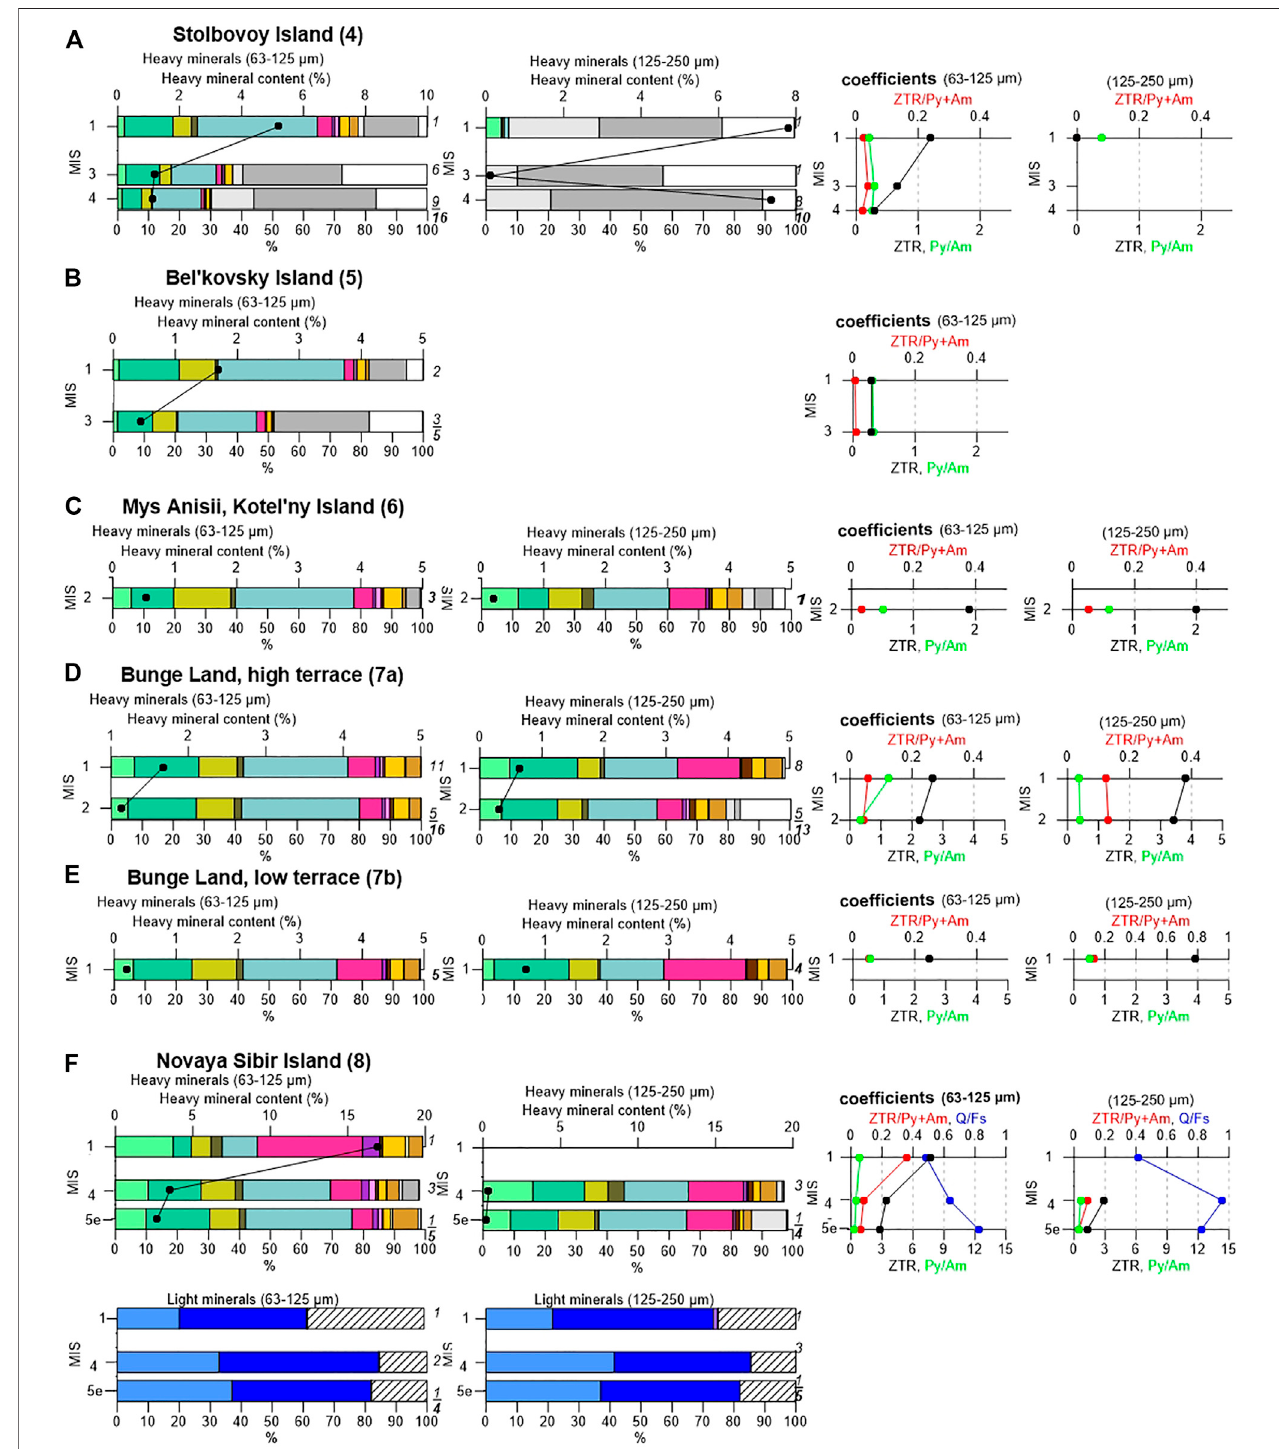
FIGURE 3 | Heavy and light mineral associations of the fi ne and coarse fractions, the heavy mineral contents, and the corresponding mineral coef fi cients from the northern New Siberian Islands: (A) Stolbovoy Island (4), (B) Bel ’ kovsky Island (5), (C) Mys Anisii, Kotel ’ ny Island (6), (D) Bunge Land, high terrace (7a), (E) Bunge Land, lowterrace (7b),and (F) NovayaSibirIsland(8).Thenumberofsamplesisinitalicstotheleftofeach diagram(notethedifferentscalesfortheheavymineralcontentsand mineral coef fi cients). For the legend, see Figure 2 .